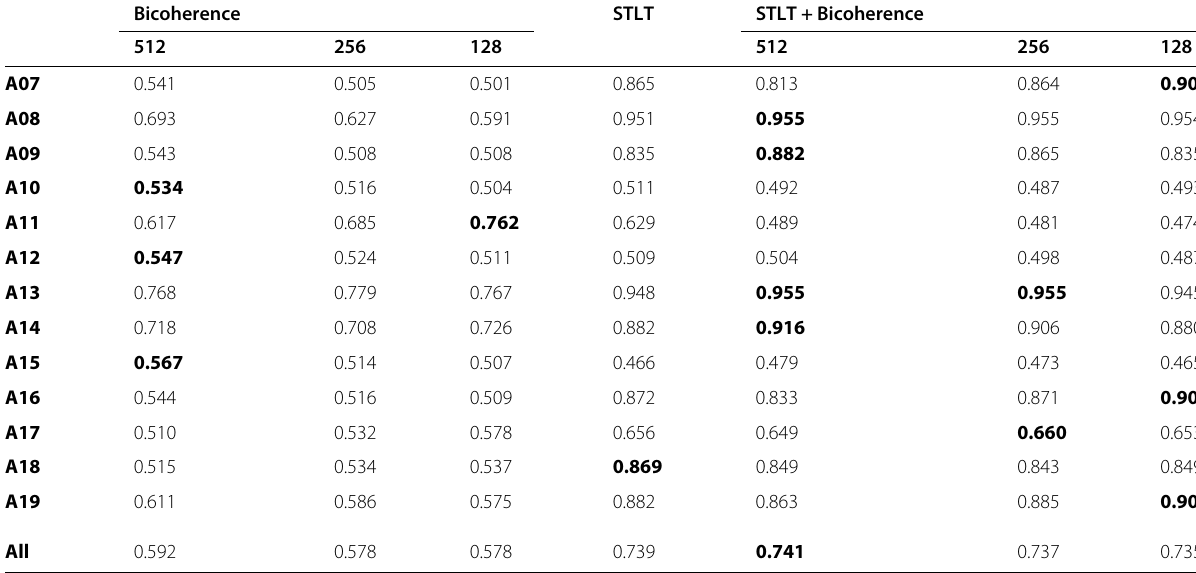
Table 3 Bona fide vs. synthetic accuracy on dataset D eval for each synthetic speech algorithm Bicoherence STLT STLT + Bicoherence 512 256